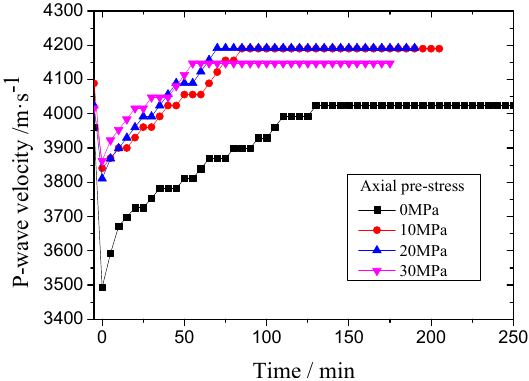
Figure 7. Time variation curve of wave velocity. Table 3. The porosity variation before and after the test.